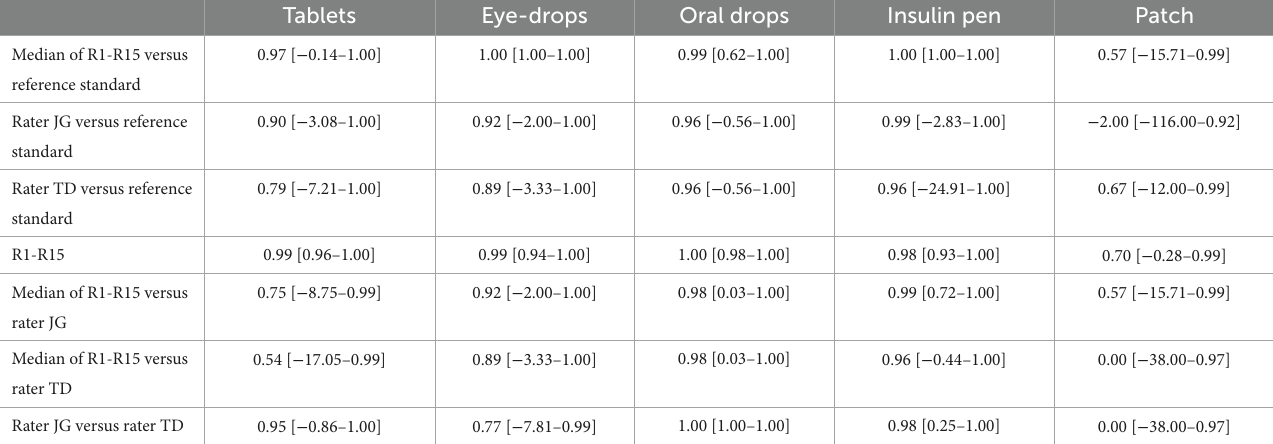
TABLE 2 Dosage form-specific interrater agreement in the pilot phase: ICC with 95% confidence intervals. Tablets Insulin pen